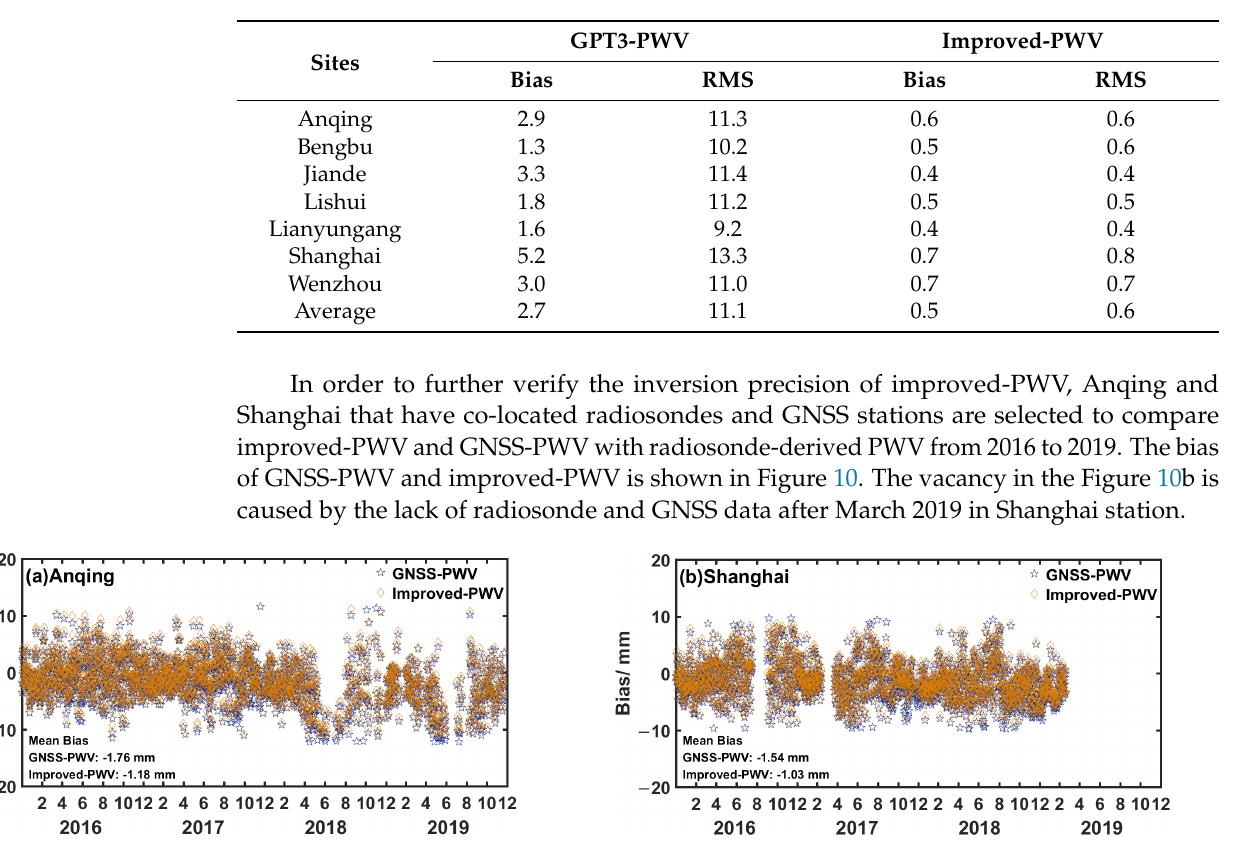
Table 5. Precision of GPT3-PWV and improved-PWV in the Yangtze River Delta during 2016–2020 (mm).